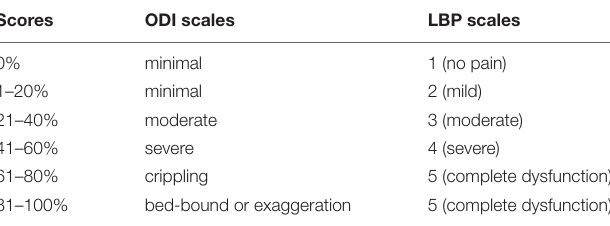
TABLE 1 | The corresponding relationship between ODI scale and LBP